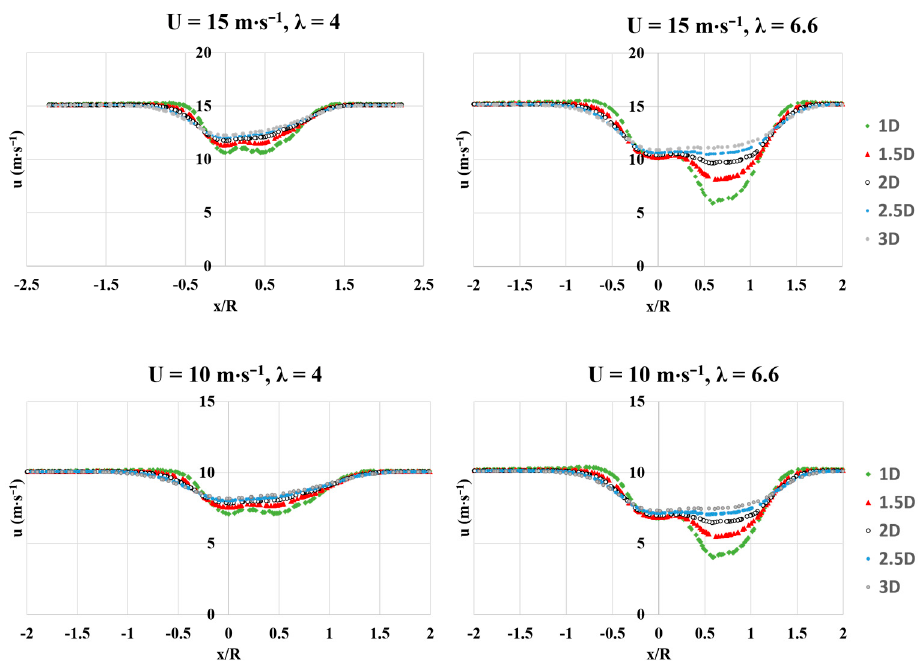
Figure 10. Wake development for two different velocity and TSR ( λ ) values.